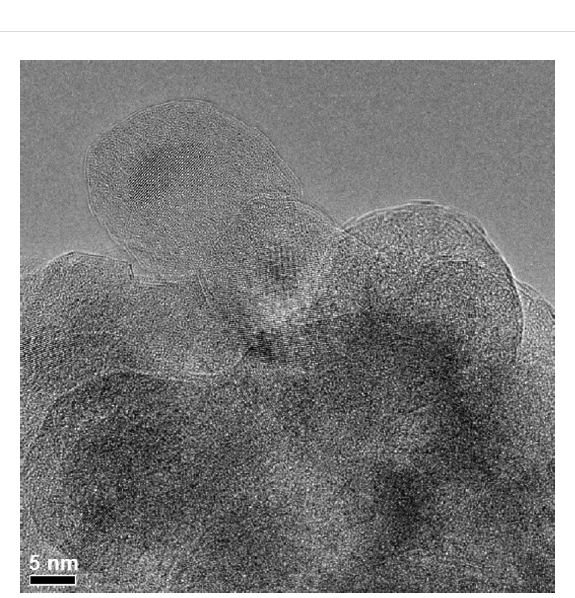
Figure 8: High-resolution TEM image of TiO 2 nanoparticles coated with Al 2 O 3 showing that the Al 2 O 3 coating is amorphous, whereas the TiO 2 cores exhibit lattice fringes proving that they are crystalline. The length of the scale bar is 5 nm.